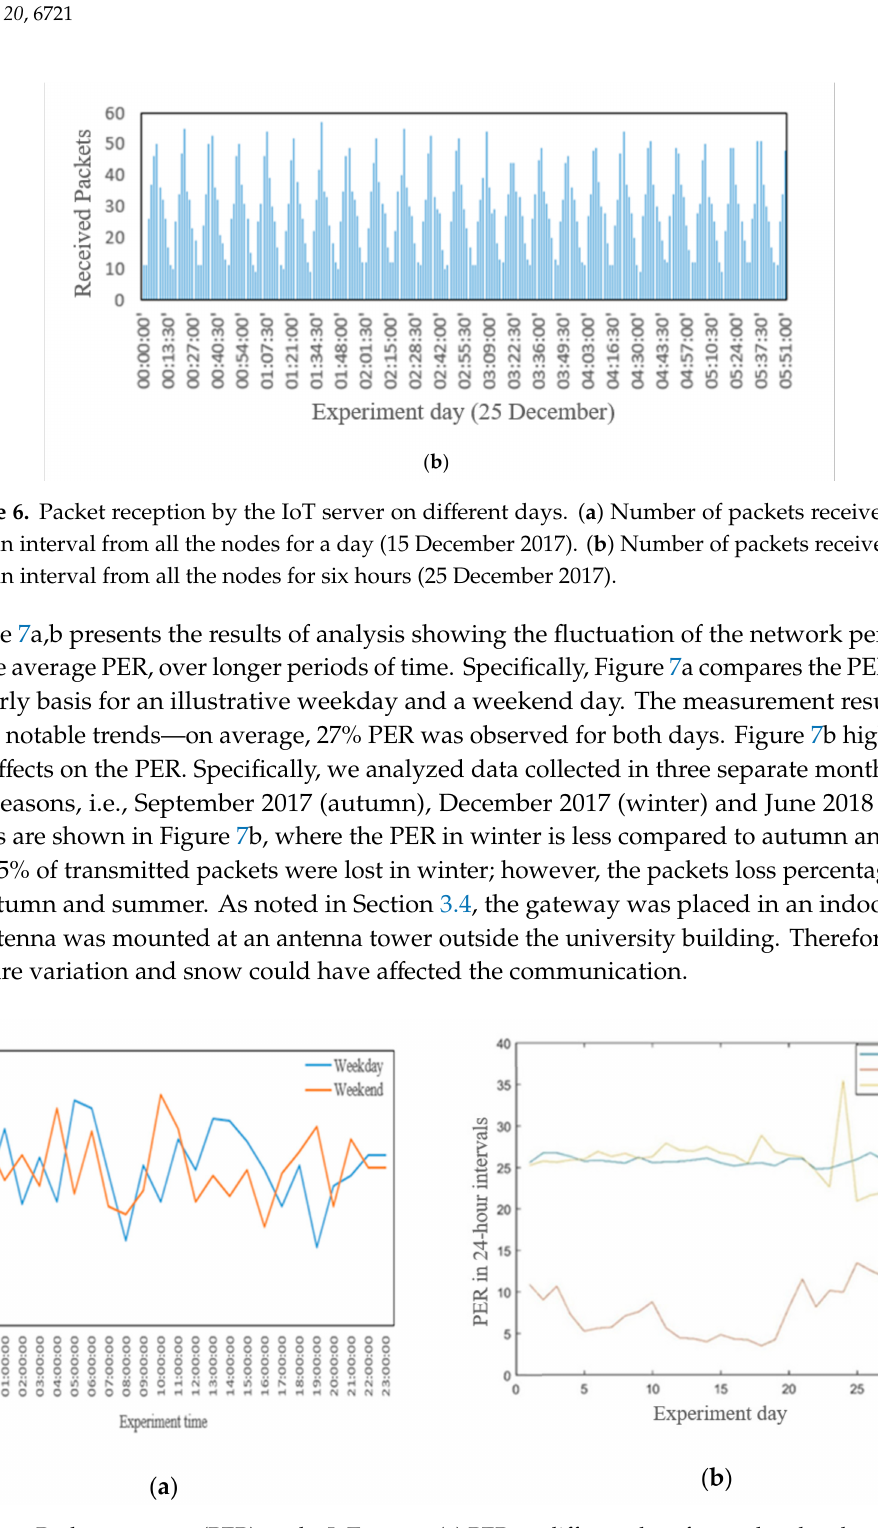
Figure 7. Packet error rate (PER) on the IoT server. ( a ) PER on di ff erent days for weekend and weekday. ( b ) PER on di ff erent days for three di ff erent months in three